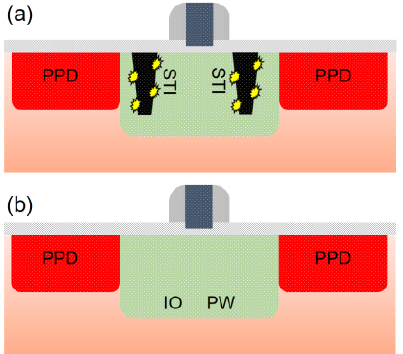
Figure 4. The schematic cross-section of GSI pixel with ( a ) STI and ( b ) merged active